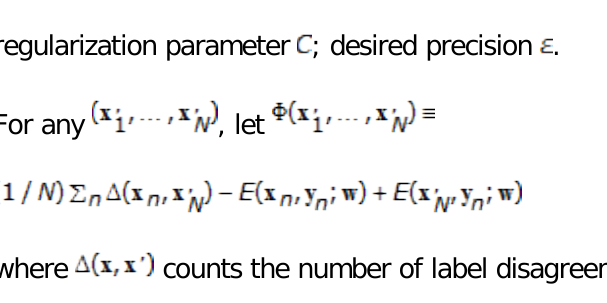
Algorithm 1: Pseudocode for our 1-slack maximum-margin learning